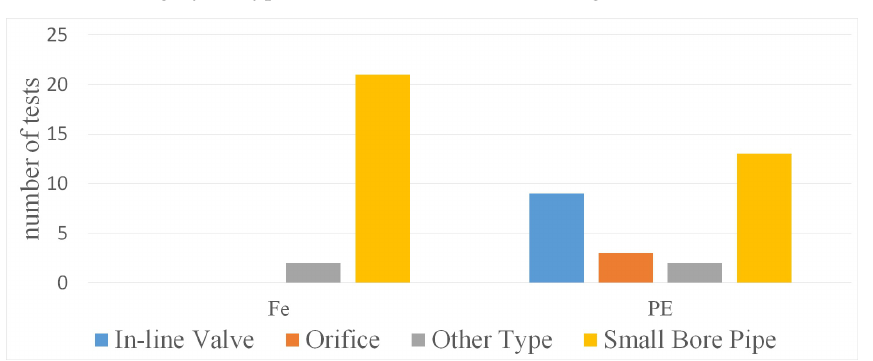
Figure 11. Pipe material and PB